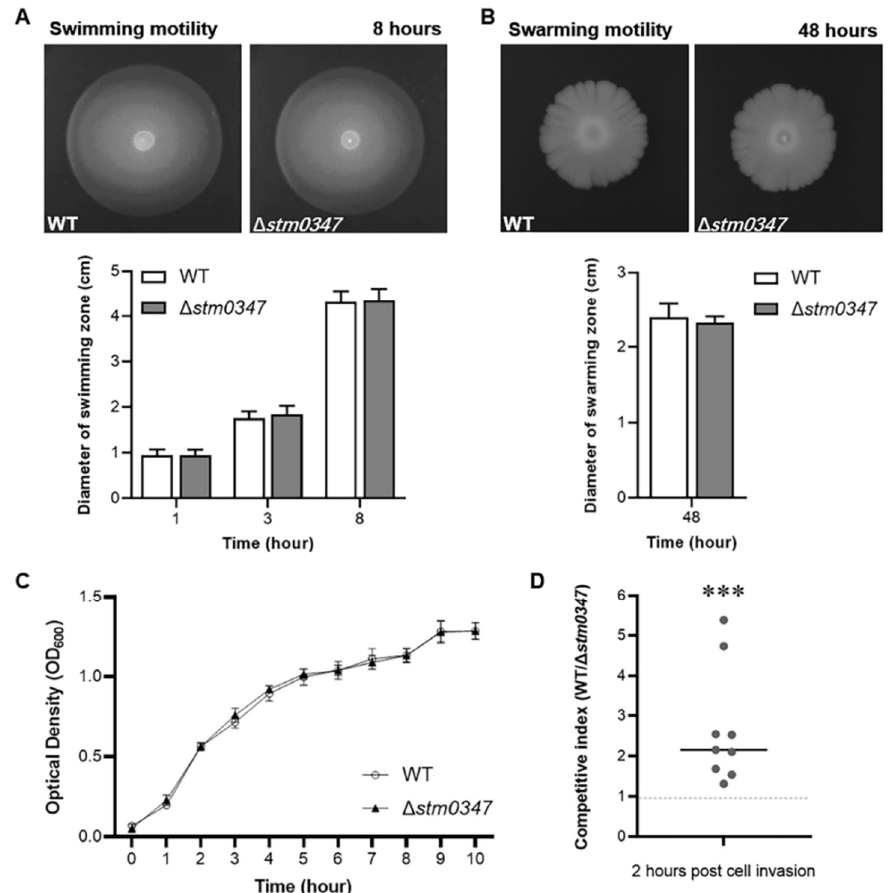
Figure 7. The absence of stm0347 does not affect S. Typhimurium motility, however disadvantageous for host cell invasion. ( A ) Swimming motility of WT and ∆ stm0347 strains were investigated on the 0.3% agar LB plate, and the diameters of the swimming zones were monitored at 1, 3, and 8 h.